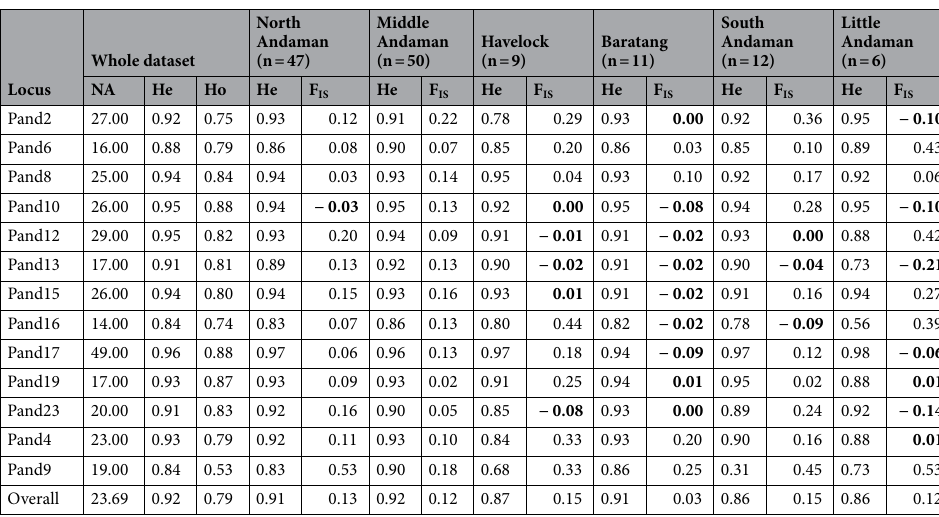
Table 2. Genetic variation summary statistics Summary statistics of the genetic variation across markers for island populations with more than two samples. NA = Number of Alleles, He = Expected heterozygosity, Ho = Observed heterozygosity, F IS = Inbreeding Coefficient. Values in bold are statistically significant, inferred using FDR correct p value ( p = 0.009356887)